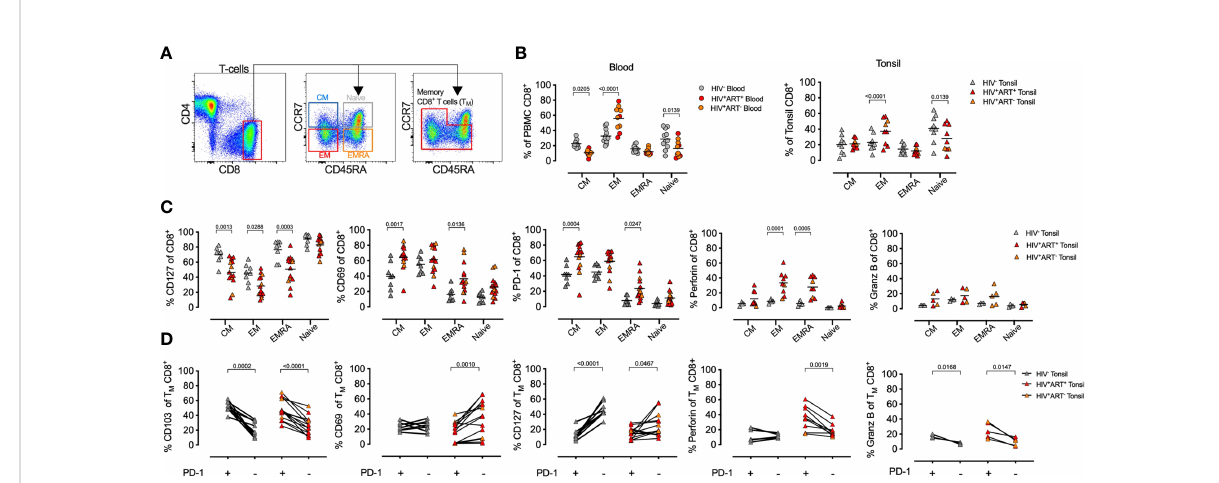
FIGURE 3 HIV infection is associated with memory CD8 + T-cell expansion in tonsils. (A) Representative FACS plot of the gating strategy of CD8 + T-cells from tonsil cells to detect naïve, T N (CCR7 + CD45RA + ), central memory (T CM , CCR7 + CD45RA - ), effector memory (T EM , CCR7 - CD45RA - ) and T EMRA (CCR7 - CD45RA + ). (B) Comparison of memory subset distribution within blood and tonsil CD8 + T-cells for central memory, T CM , Effector memory, T EM , transitional, T EMRA , T Naive with cumulative memory subset distribution of CD8 + T-cells for blood ( n= 21, circles, left) and tonsil ( n= 22, triangles, right). (C) Distribution of tonsil central memory (T CM ), transitional memory (T EMRA ), effector memory (T EM ) and naïve subsets within CD127, CD69, PD-1, perforin and GZMB expressing CD8 + T-cells cumulative for all study participants in HIV - (grey), HIV + ART + (red) and HIV + ART - (orange). P-values calculated using ordinary one-way ANOVA with horizontal bars representing median values with the level of signi fi cance indicated above. (D) The frequency of CD103, CD69, CD127, perforin, and GZMB cells measured on PD-1 + (left) and PD-1 - (right) CD8 + T-cells from tonsil in HIV+ (red) and HIV - (grey) individuals. P-values calculated using Paired Student ’ s t-test. Horizontal bars represent median